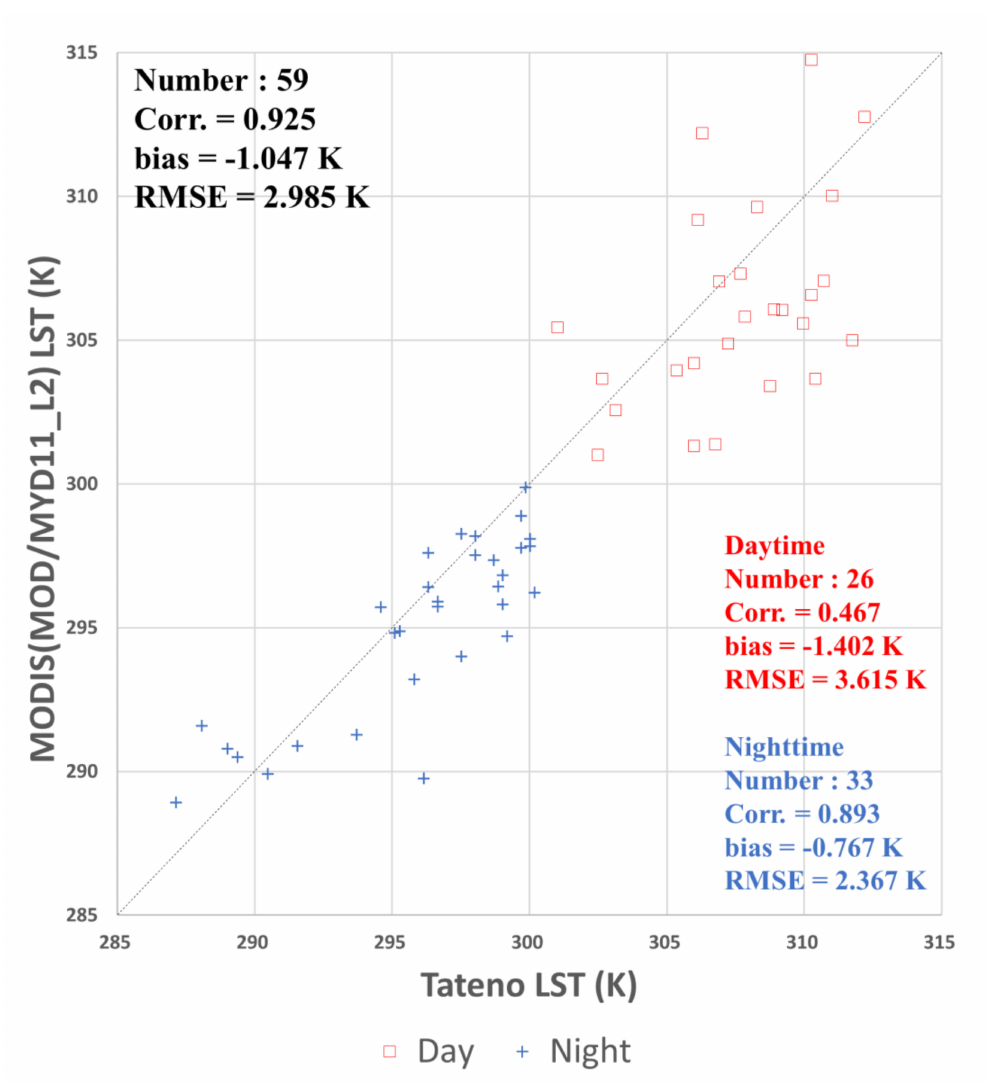
Figure 13. Scatter plot between the MODIS (MOD11_L2 / MYD11_L2) LST and the LST at Tateno station from upward longwave radiation (red square symbol: daytime; blue cross symbol: nighttime; gray dotted line represents the 1:1